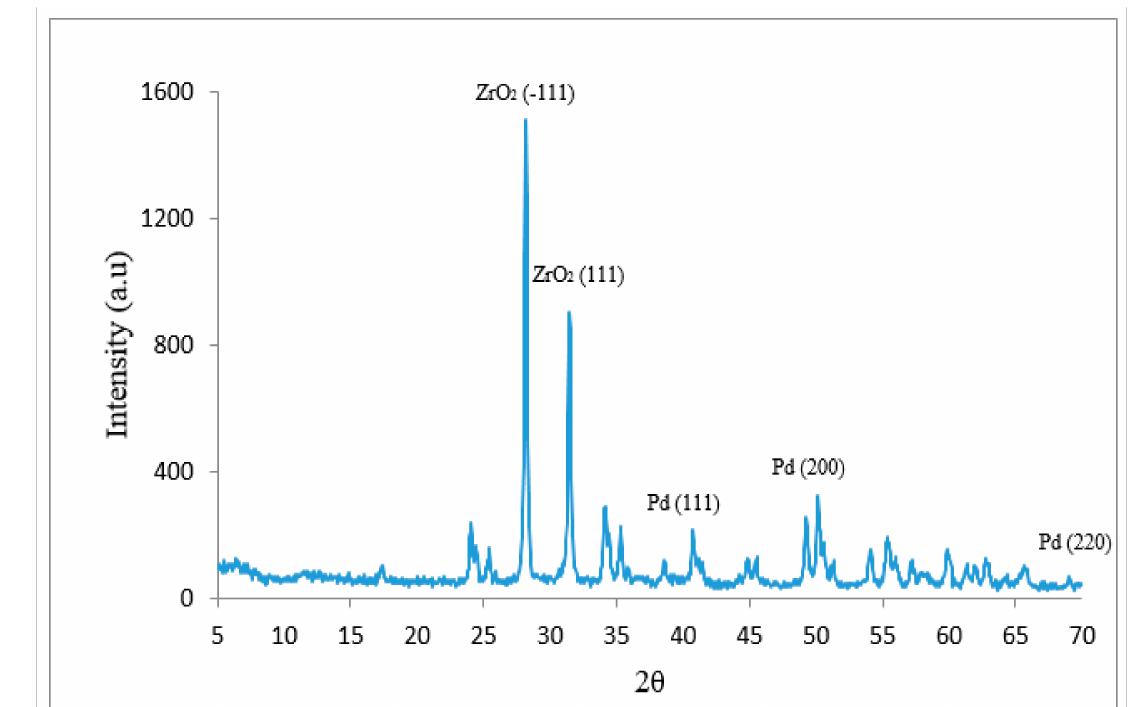
Figure 5. XRD pattern of Pd/ZrO 2 .